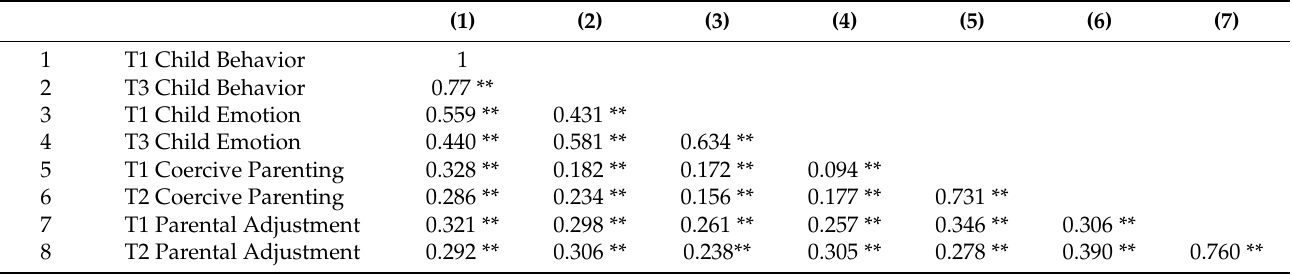
Table 4. Cross-correlation between